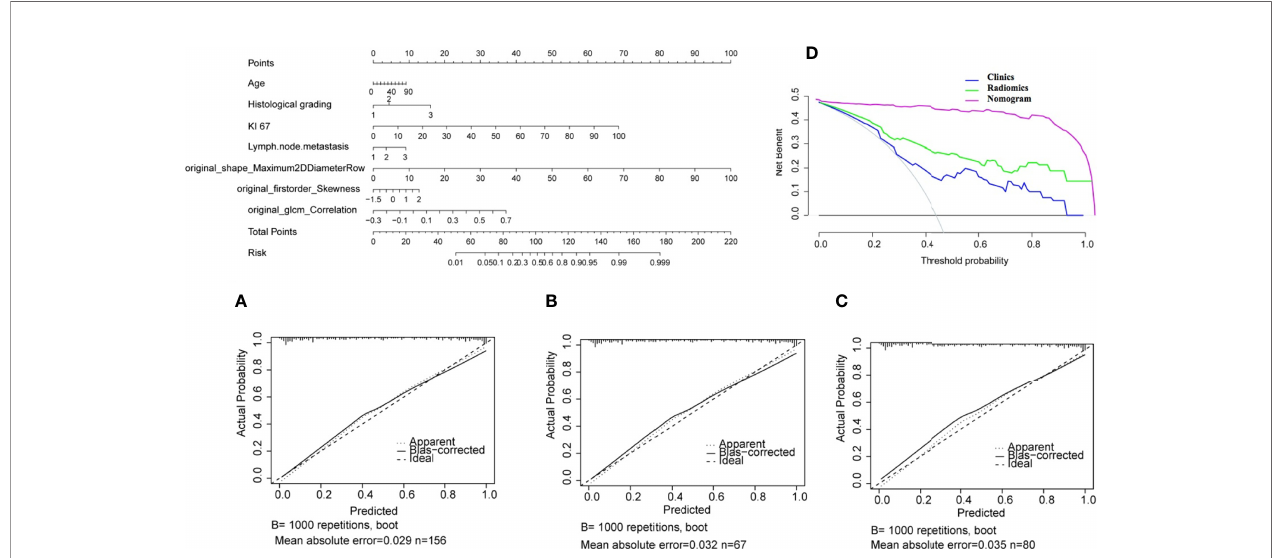
FIGURE 5 | Nomogram for classifying HR+/Luminal and HER2-enriched molecular subtypes of breast cancer. (A – C) Calibration curves of the nomogram in the training, test, and external validation sets, respectively. (D) Decision curve analysis of the